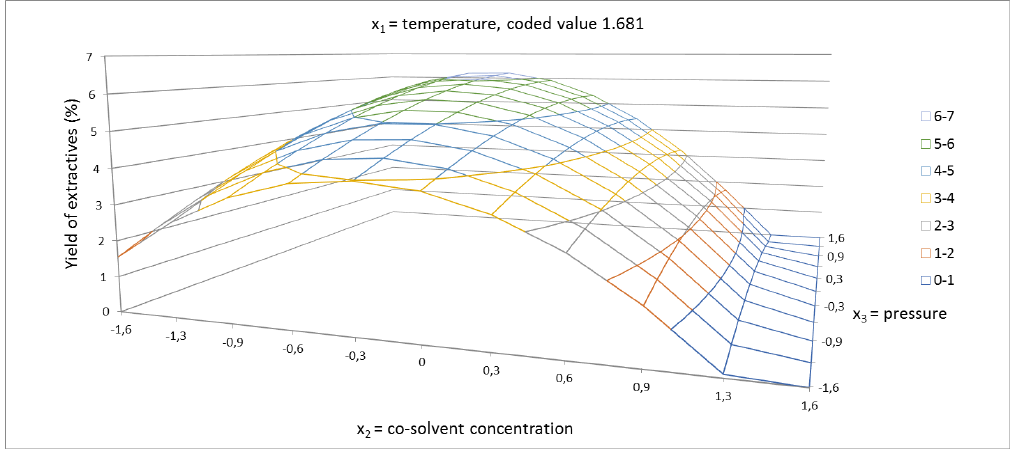
Figure 4. Response surface of extractives yield (%) as a function of cosolvent concentration of 40–96.6% EtOH/water and pressure in the range of 1050–9000 psi, in coded values, at constant temperature of 70 °C (coded value + 1.681).